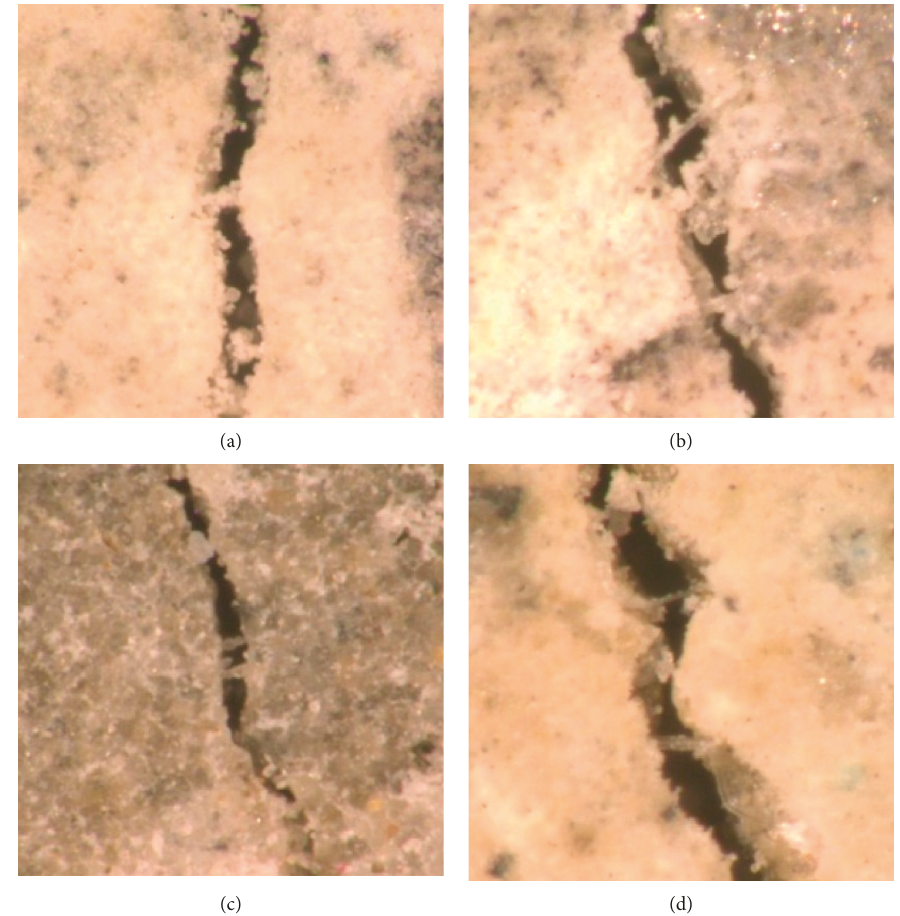
Figure 10: Optical microscopic images observed the crack surface: (a) PE-W, (b) PE-A, (c) PVA-W, and (d)